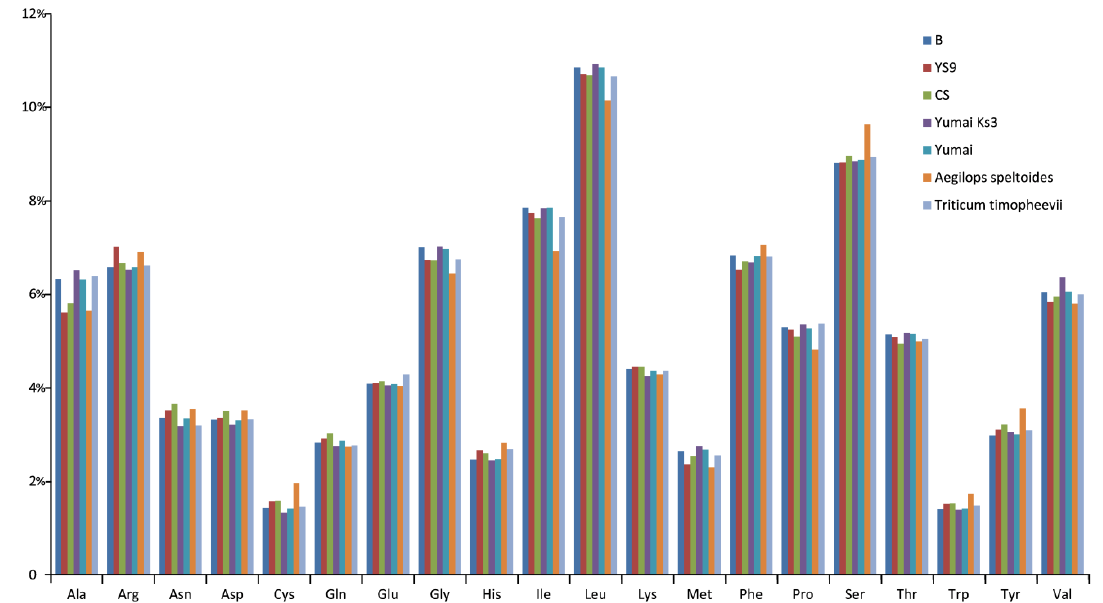
Figure 4. Codon usage patterns of B and YS9 wheat mitogenomes compared with those of the other five higher plants. The ratio of each amino acid residue to the whole mitochondrial proteins is shown as a percentage on the